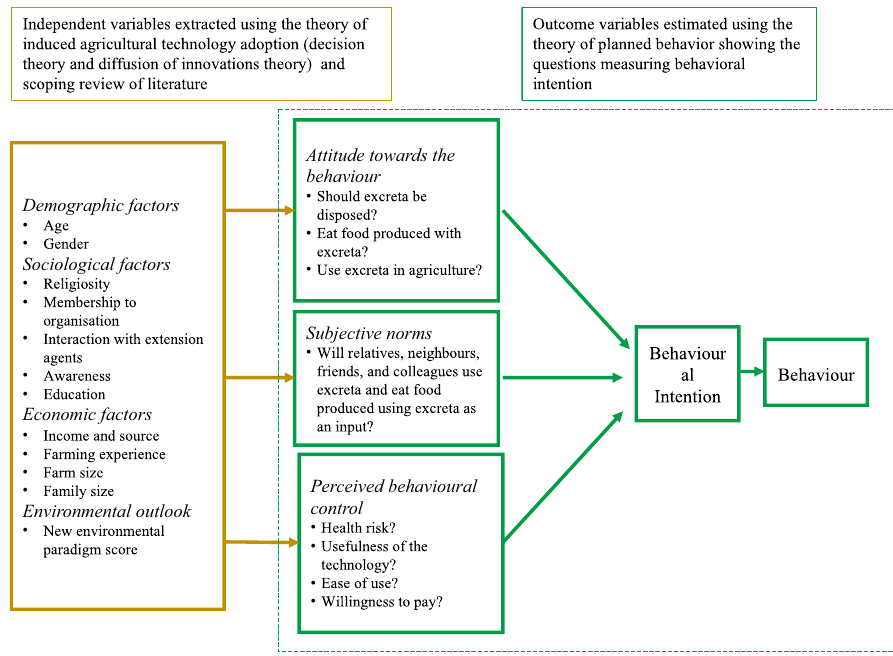
Figure 1. A Diagram of factors that influence behavioral intention to recycle human excreta in agriculture: a conceptual